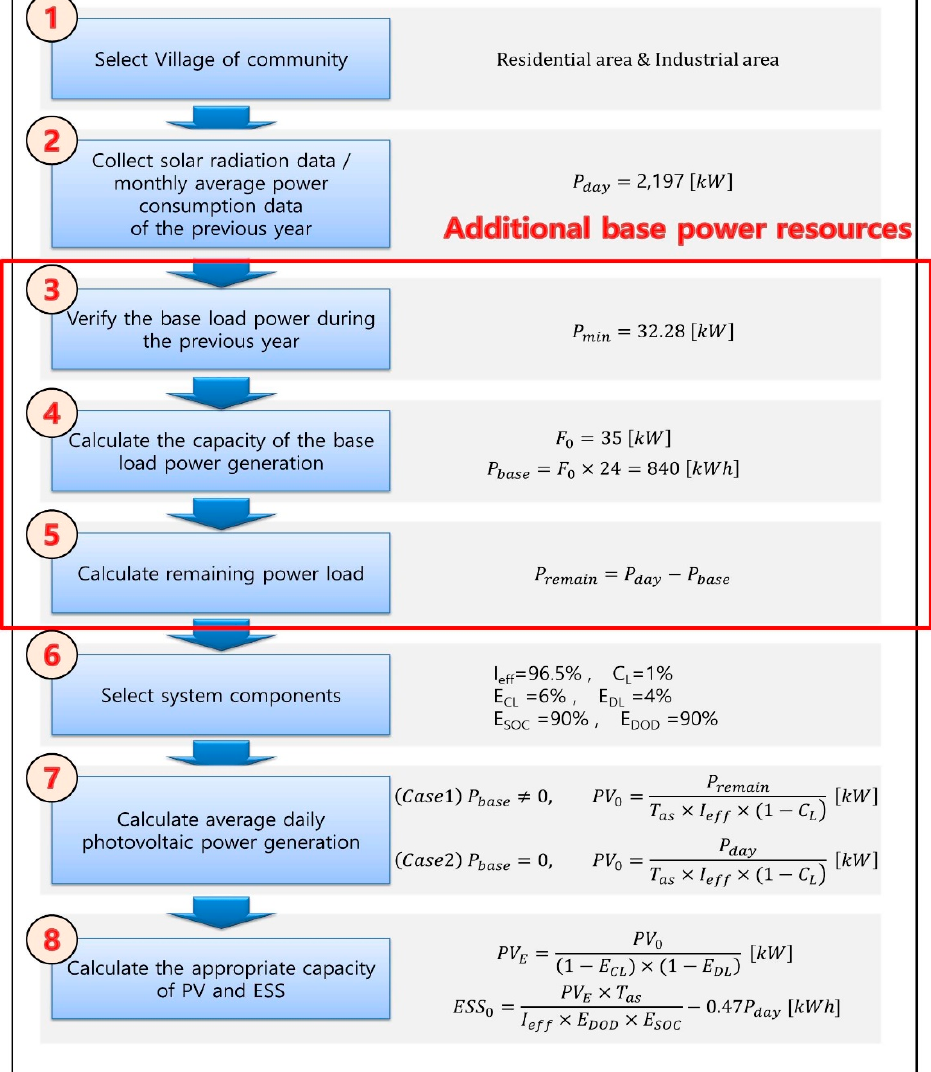
Figure 2. Flow chart of the system design method.